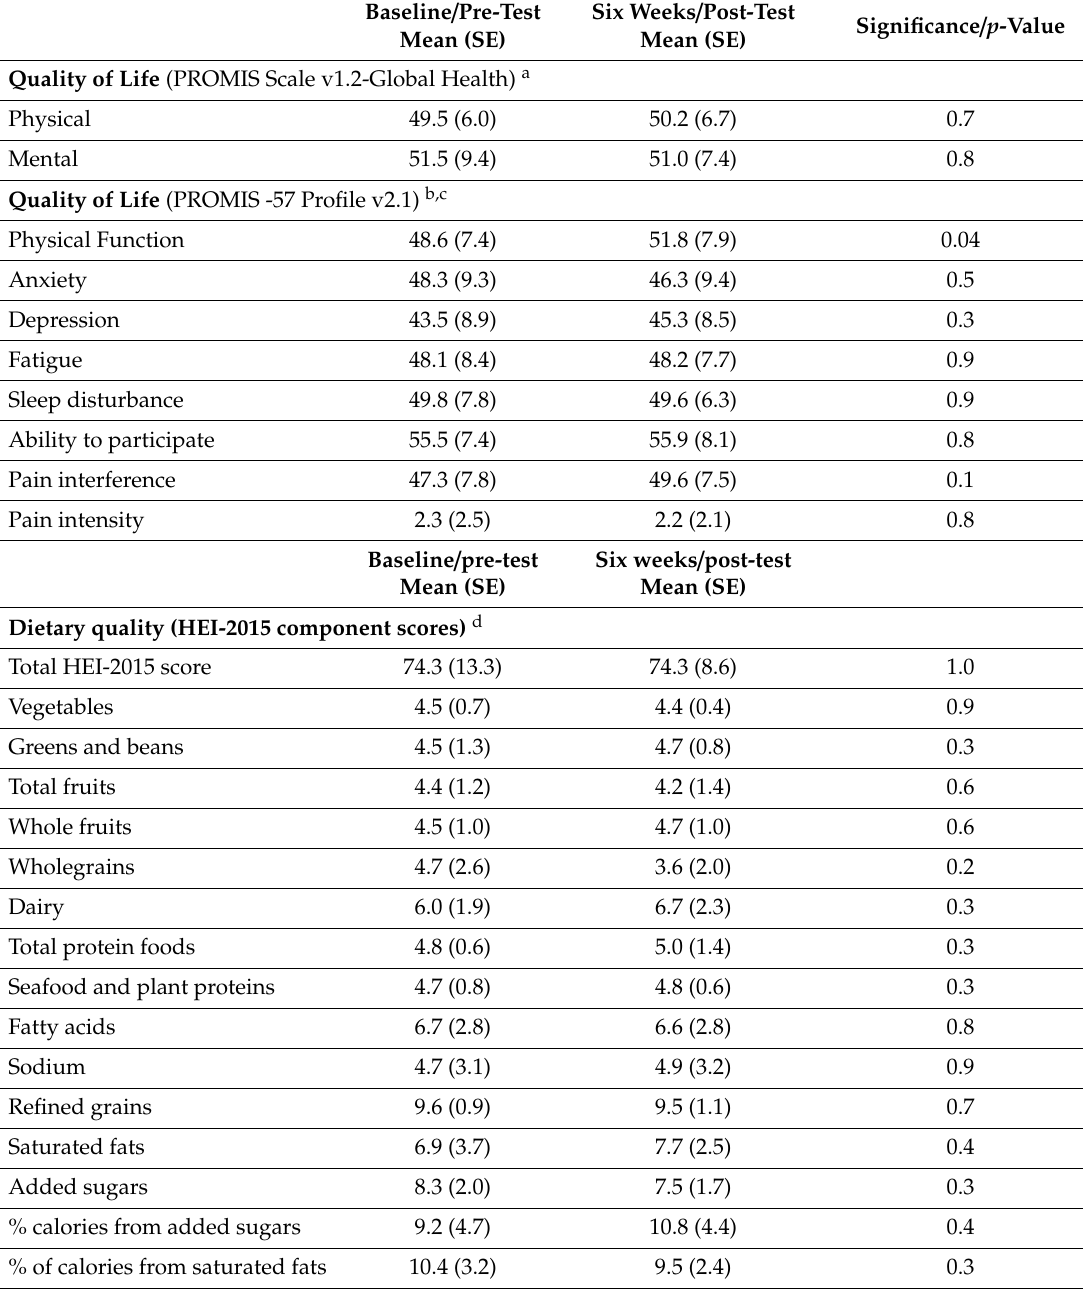
Table 2. Changes in quality of life and dietary quality after 6 weeks